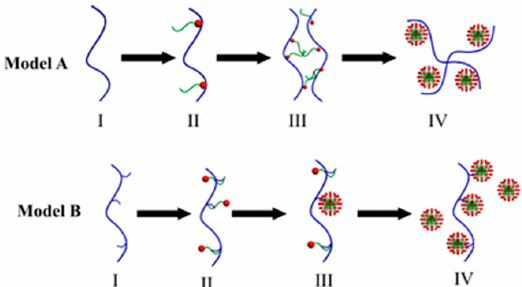
Figure 11. Two proposed mechanisms of the binding interaction between PVPNO and SDS at low (Model A) and high (Model B) pH values. Reprinted with permission from Wang, H.; Fan, Y.; Wang, Y. Thermodynamic association behaviors of sodium dodecyl sulfate (SDS) with poly(4-vinylpyridine N -oxide) (PVPNO) at different pH values and ionic strengths. J. Surfactants Deterg . 2017 , 20 , 647–657, doi:10.1007/s11743-017-1939-7. Copyright 2017, John Wiley and Sons